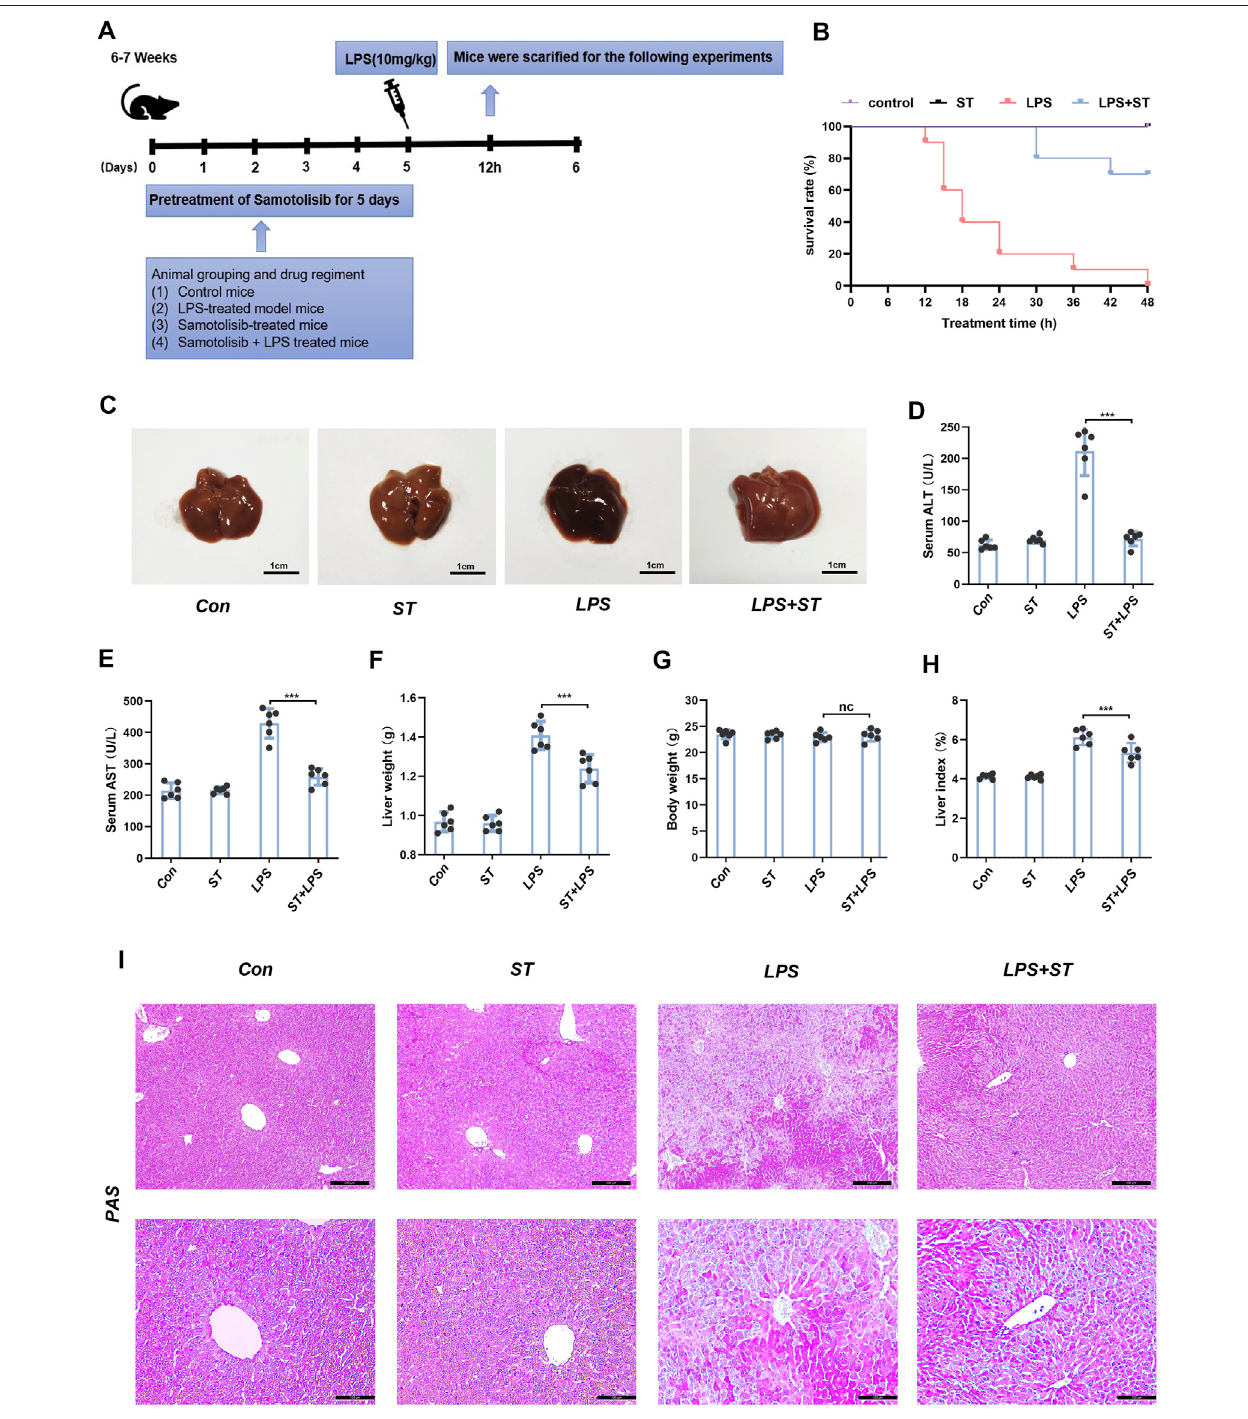
FIGURE2| SamotolisibimprovedsurvivalandliverinjuryinducedbyLPS. (A) Mice( n (cid:1) 6pergroup)werepre-treatedwithvehiclephosphate-bufferedsaline(PBS) or ST (5 mg/kg, respectively) 1 h prior to the LPS (10 mg/kg) challenge, respectively. (B) Survival curves. (C) Representative images of liver tissues. (D) Plasma levels of ASTand (E) ALT. (F) Liverweight. (G) Bodyweight. (H) Liverindex. (I) PASstainingofliversection(scalebars (cid:1) 200and100 μ m).Dataarepresentedasthemean ± SD; n (cid:1) 10 (for survival rate analysis) or 6; * p < 0.05, ** p < 0.01, *** p < 0.005.